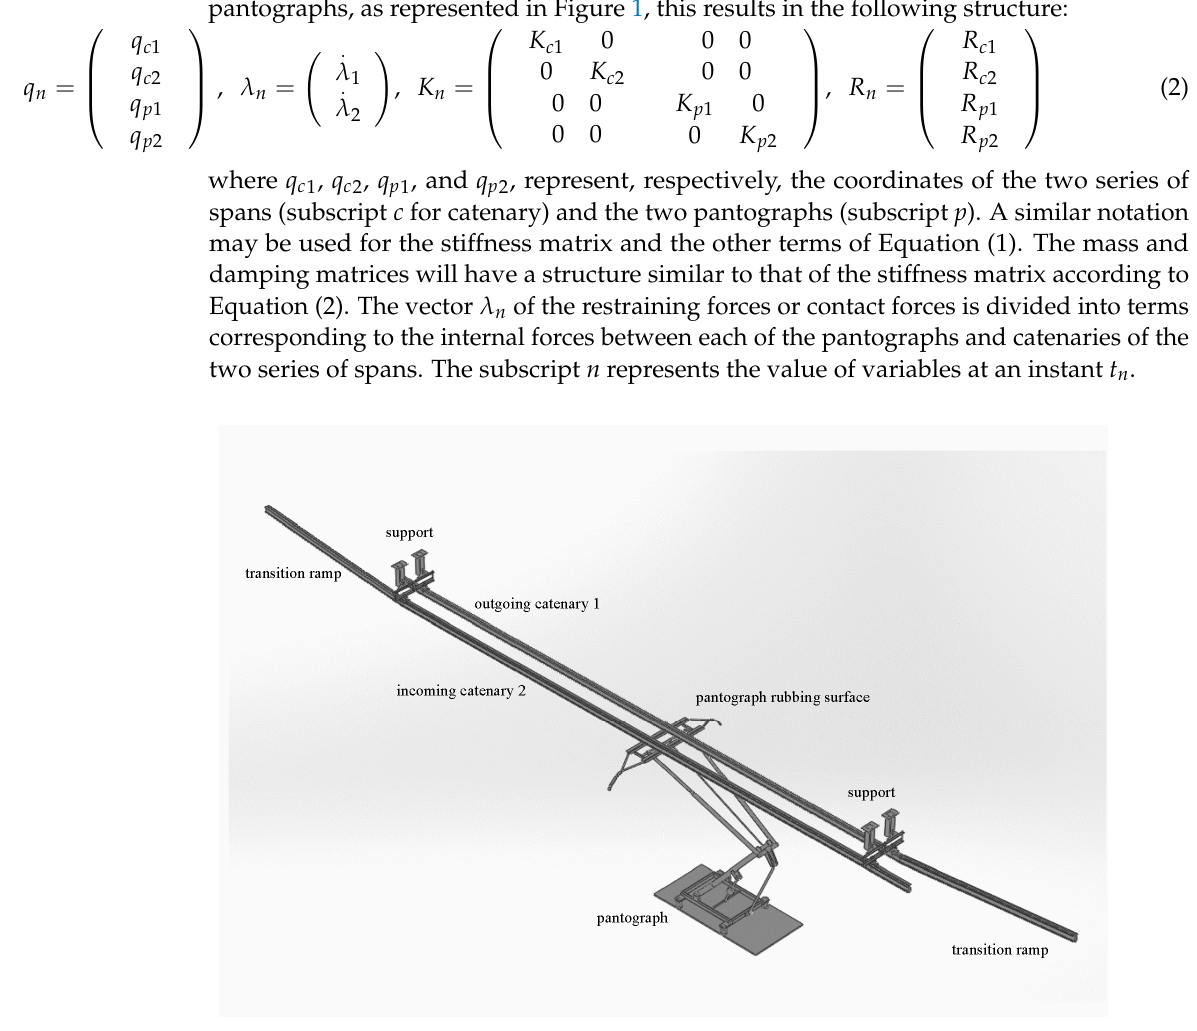
Figure 1. Interaction of one pantograph with two catenaries.